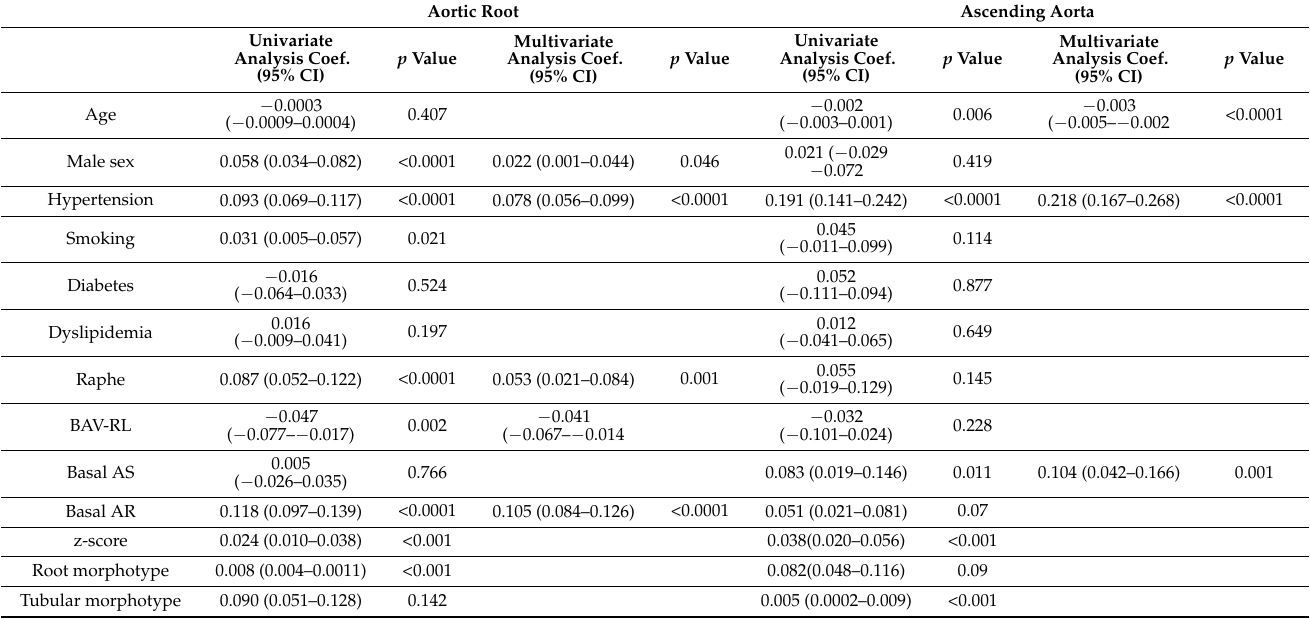
Figure 1. Histograms showing the distribution of mean annual growth rates of aortic root ( A ) and ascending aorta ( B ) diameters.